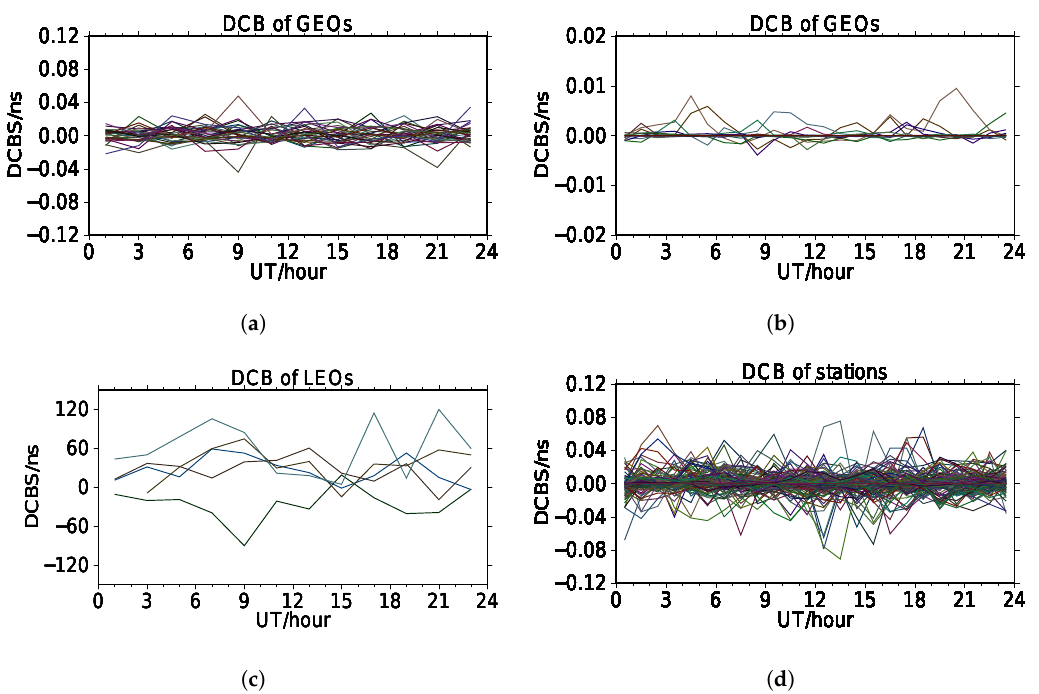
Figure 2. Corrected DCB value of assimilation: ( a ) DCBs’ corrected value of GPS satellites from the assimilation for the top region; ( b ) DCBs’ corrected value of GPS satellites from the assimilation for the bottom region; ( c ) DCBs’ corrected value of LEO satellites from the assimilation for the top region; and ( d ) DCBs’ corrected value of stations from the assimilation for the bottom region. The data for the top region can be referenced by using the podTec data from COSMIC. On DOY 10, 2008, the observations were concentrated mainly at 2–10 TECU, the RMS DCBs of the GPS observations were approximately 0.023 ns, and the LEO RMS DCB reached 0.5 ns or even 0.765 ns. At the same time, Lin found that DCB errors of COSMIC satellites showed a parabolic change with the elevation angle in the DCB estimation for GPS/LEO. When the elevation angle was 15 ◦ , the DCB errors of COSMIC satellites reached the lowest value with 0.24 TECU, and the errors at elevation angles of and were 0.4 TECU and 0.56 TECU, respectively [27]. In the assimilation process, the fixed error and the proportional error of the observation error were 0.5 TECU and 0.12, respectively, and the specific weighted DCB error reached or exceeded the background field model error, indicating that the podTec error was absorbed by the DCB of GPS/LEO during the assimilation of the top ionospheric region. Therefore, the DCB correction of GPS/LEO could be 30–40 ns or even more than 80 ns in Figure 2c. For the assimilation of the bottom region, on DOY 10, 2008, the ground-based GNSS STEC observation was generally distributed at 30–100 TECU, and the RMS DCB of each station was generally within 0.1 ns. The fixed error and the proportional error of the observation error during the assimilation process were 0.5 TECU and 0.15, respectively. Therefore, the DCB error proportion was extremely low compared with the background field and observation data errors; however, if the RMS DCB of a station was extremely large, the observation data of that station can be suppressed. Figure 2b,d demonstrate that the DCB corrections for the satellites and stations during the assimilation process were extremely small (all below 0.5 ns), which is consistent with the stability of DANG´s work [28] through multisource data fusion to solve GIMs and